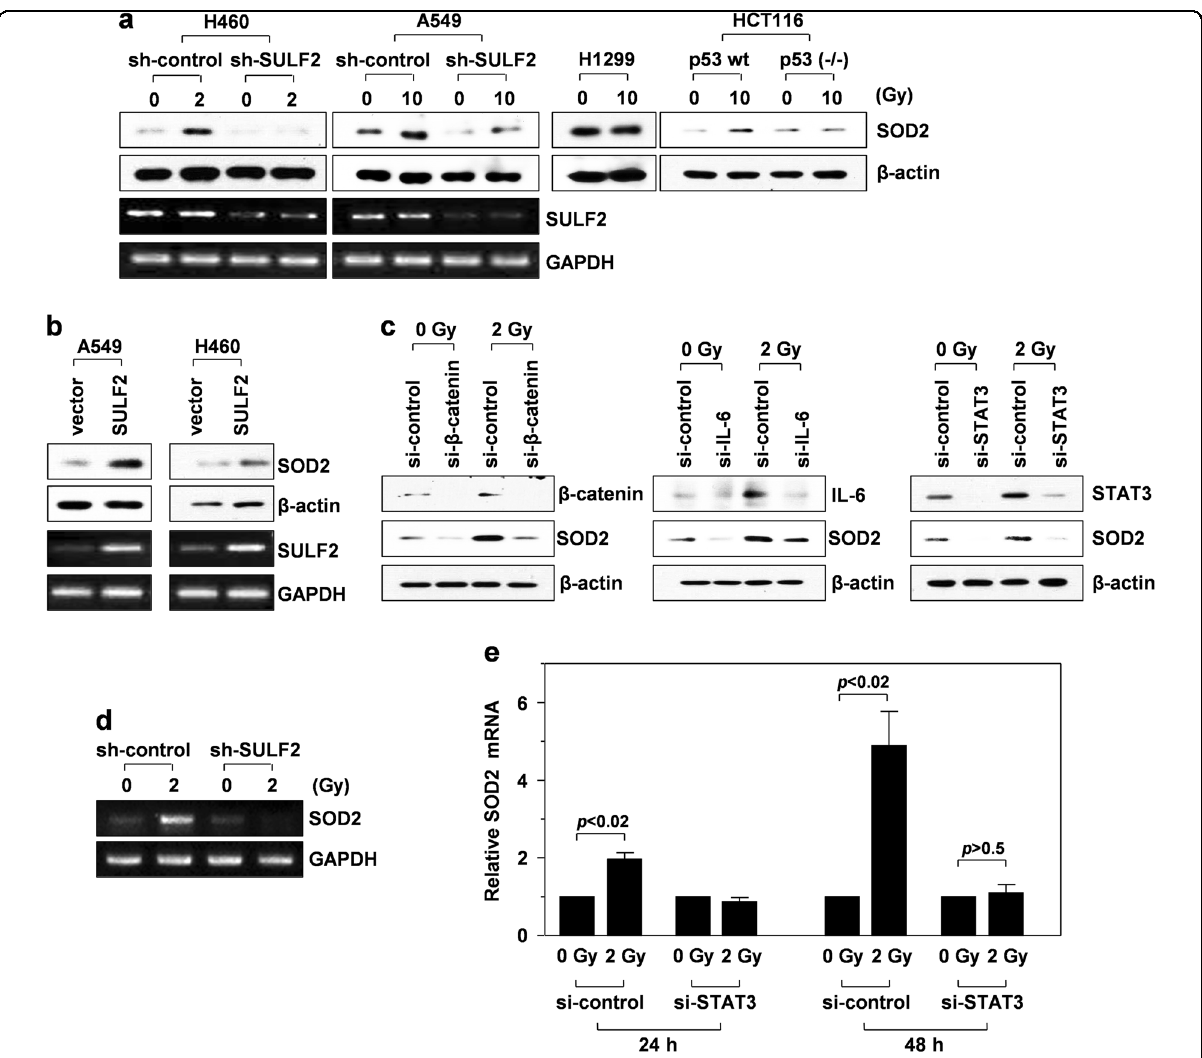
Fig. 1 IR induces SOD2 expression via the p53/SULF2/ β -catenin/IL-6/STAT3 pathway. a – d Western blotting and RT-PCR were performed 48 h after γ -irradiation. a H460 and A549 lung cancer cells (p53 wt ) were infected with lentiviruses expressing control (nontargeting sequence) or SULF2- speci fi c shRNA. These transfectants, along with H1299 lung cancer cells (p53 null ) and p53 wt -expressing or p53-knockout HCT116 colon cancer cells, were irradiated with the indicated doses of γ -rays, and SOD2 levels were compared by western blot analysis using β -actin as a loading control. SULF2 expression was compared by RT-PCR using GAPDH as a loading control. b A549 and H460 cells were transfected with an empty or SULF2 expression vector, and SOD2 protein and SULF2 mRNA levels were compared. c H460 cells treated with a control or an siRNA targeting β -catenin, IL-6, or STAT3 were irradiated with 2 Gy of γ -rays, and the levels of the indicated proteins were compared. d H460 cells infected with the lentiviruses indicated in a were irradiated, and SOD2 mRNA levels were analyzed by RT-PCR. e H460 cells treated with a control or a STAT3-targeting siRNA were irradiated, and SOD2 mRNA levels were compared by quantitative real-time PCR at 24 and 48 h after